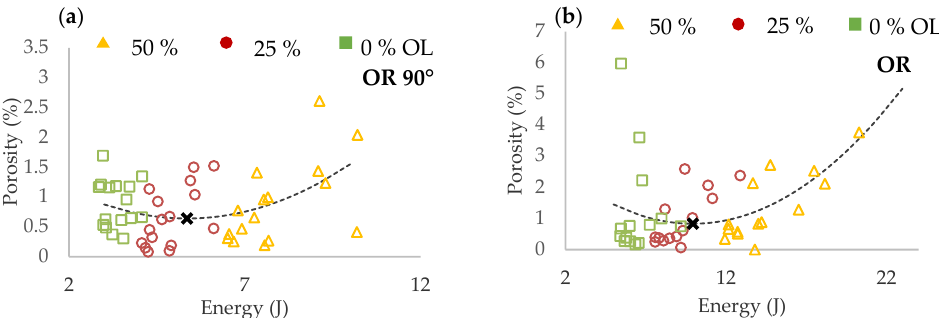
Figure 9. Porosity vs. input energy dependence ( a ) for inclination 90°; ( b ) for inclination 35.26°.